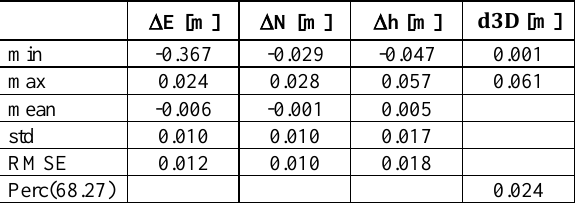
Table 2. Descriptive statistics for the whole filtered dataset